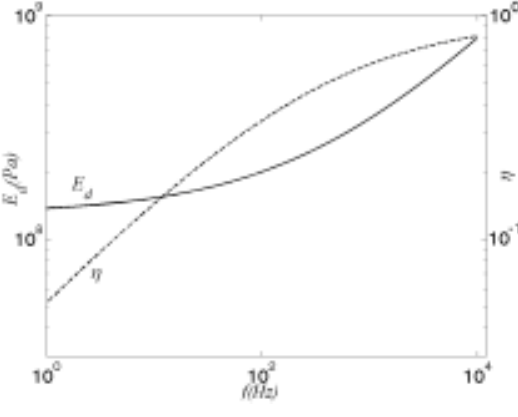
Fig. 5. Frequency dependent properties of the viscoelastic material.